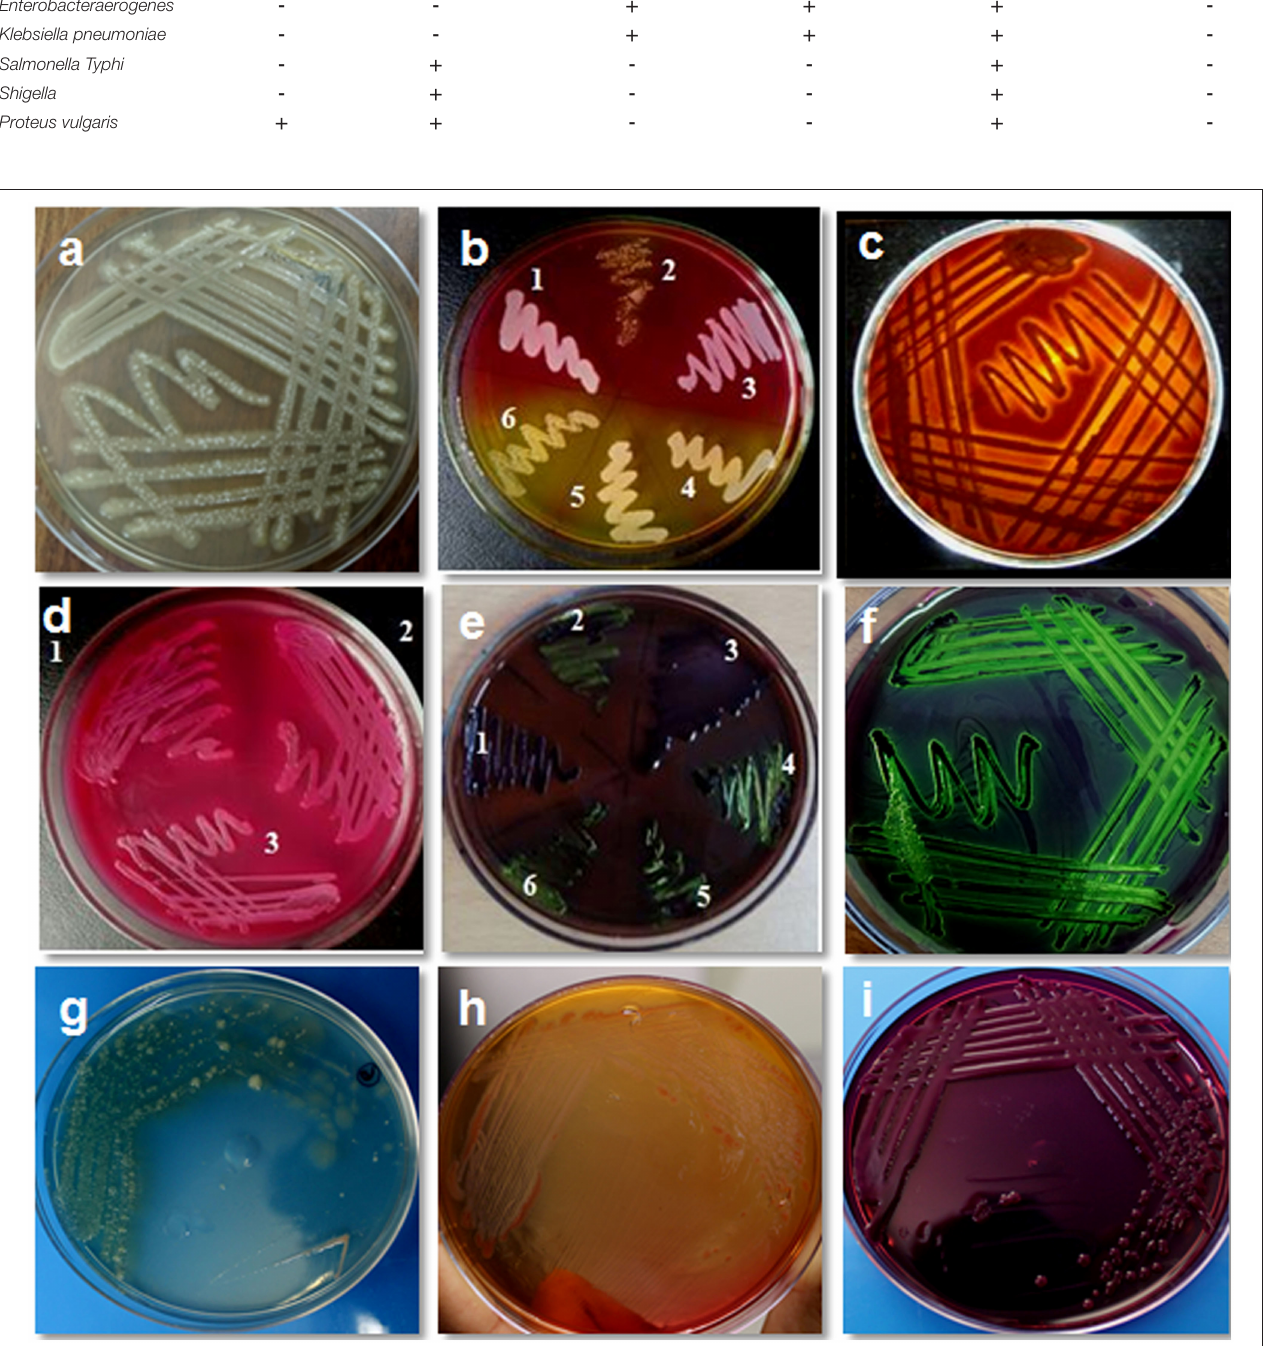
FIGURE 1 | Isolation and cultural characteristics of bacterial isolates from bovine mastitis milk. (a) Staphylococcus aureus on nutrient agar showing mucoid colonies; (b) growth of S. aureus on mannitol salt agar showing yellow colonies (4,5,6) whereas S. epidermidis show pink colonies (1,2,3) (c) S. aureus on blood agar showing β hemolysis; (d) growth of E. coli on MacConkey agar (lactose fermenting, pink colonies); (e) growth of E. coli on EMB agar (typical green metallic sheen) sample no. 2, 4, 5, 6; (f) E. coli showing typical green metallic sheen on EMB agar; (g) Pseudomonas on nutrient agar showing blue-green colony; (h) Pseudomonas on MacConkey agar showing mucoid colony; (i) Klebsiella on EMB agar showing mucoid colony.